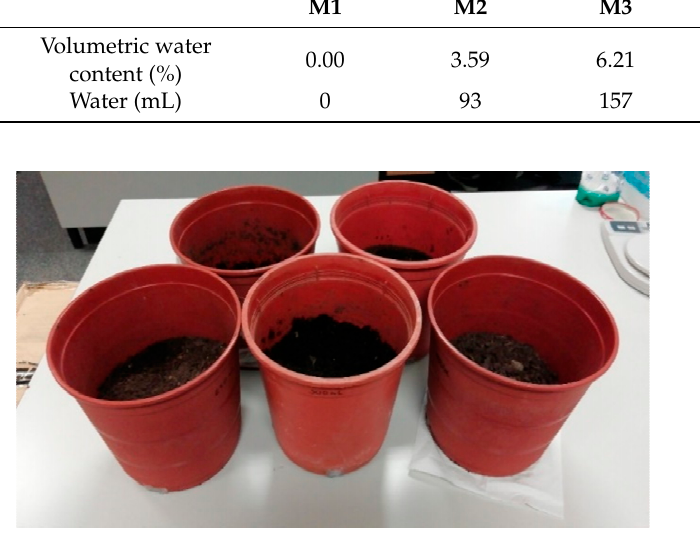
Figure 4. Pots with different moisture for the first set of tests.